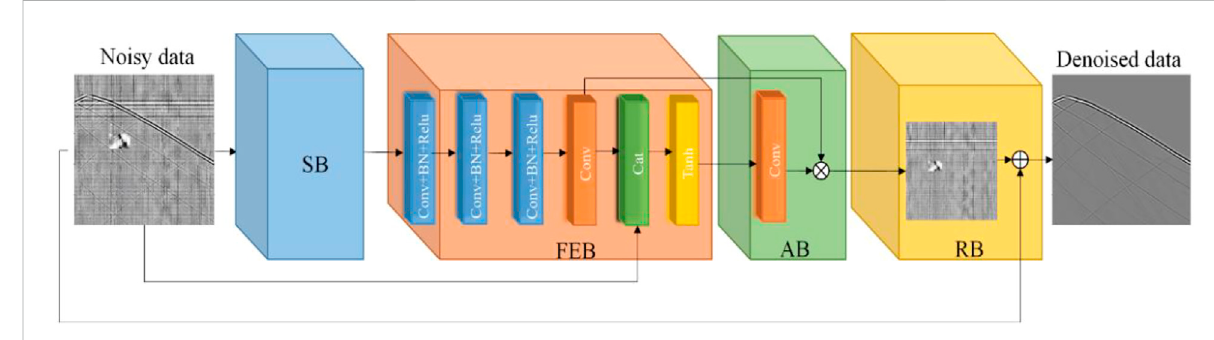
FIGURE 1 Architecture of ADNet (According to Tian et al. (2020), we modi fi ed Figure 1).